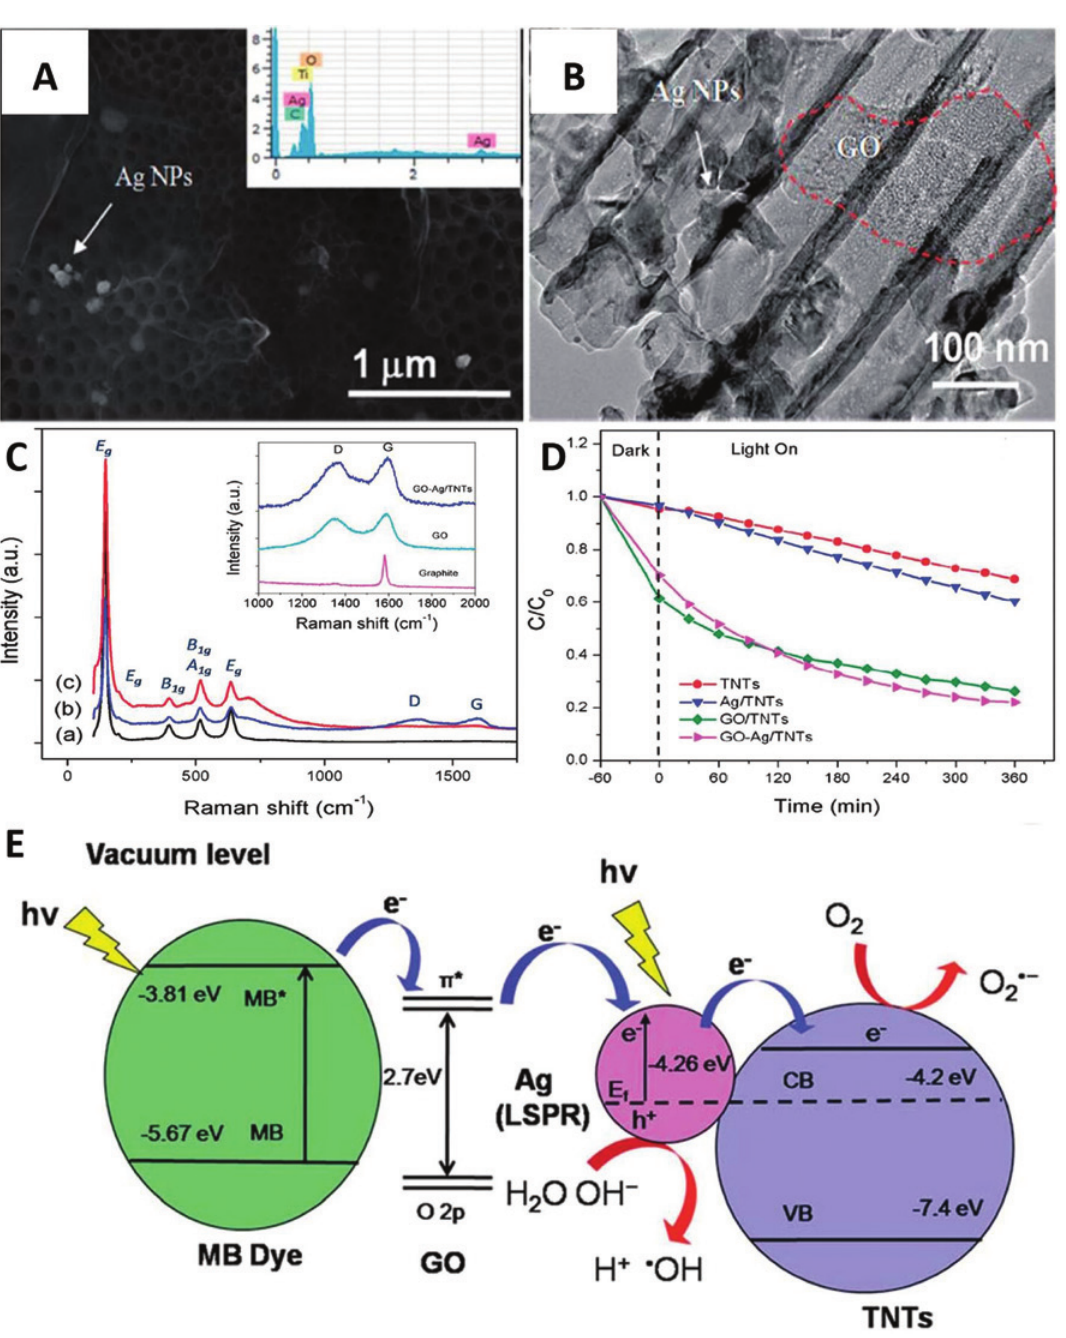
NTAs (A). Inset (A) is the EDX spectra. (C) Raman spectra of bare TNTs (a), GO-Ag/TNTs Figure 20: SEM (A) and TEM (B) images of GO/Ag/TiO 2 (b), Ag/TNTs (c). Photocatalytic degradation rates of MB for bare TNTs, Ag/TNTs, GO/TNTs, and GO-Ag/TNTs under visible light irradiation (D). Schematic diagrams of electron transfer and degradation mechanism of MB (E). Reproduced from Ref. [224] with permission. Copyright Royal Society of Chemistry